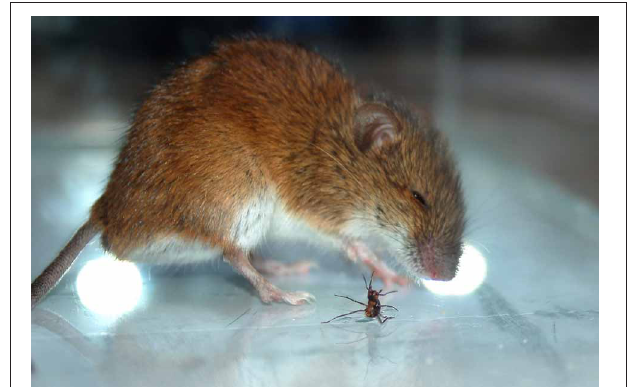
FIGURE 1 | An ant exhibits the aggressive posture and splash acid toward mouse’s eyes. Photo by Yu.